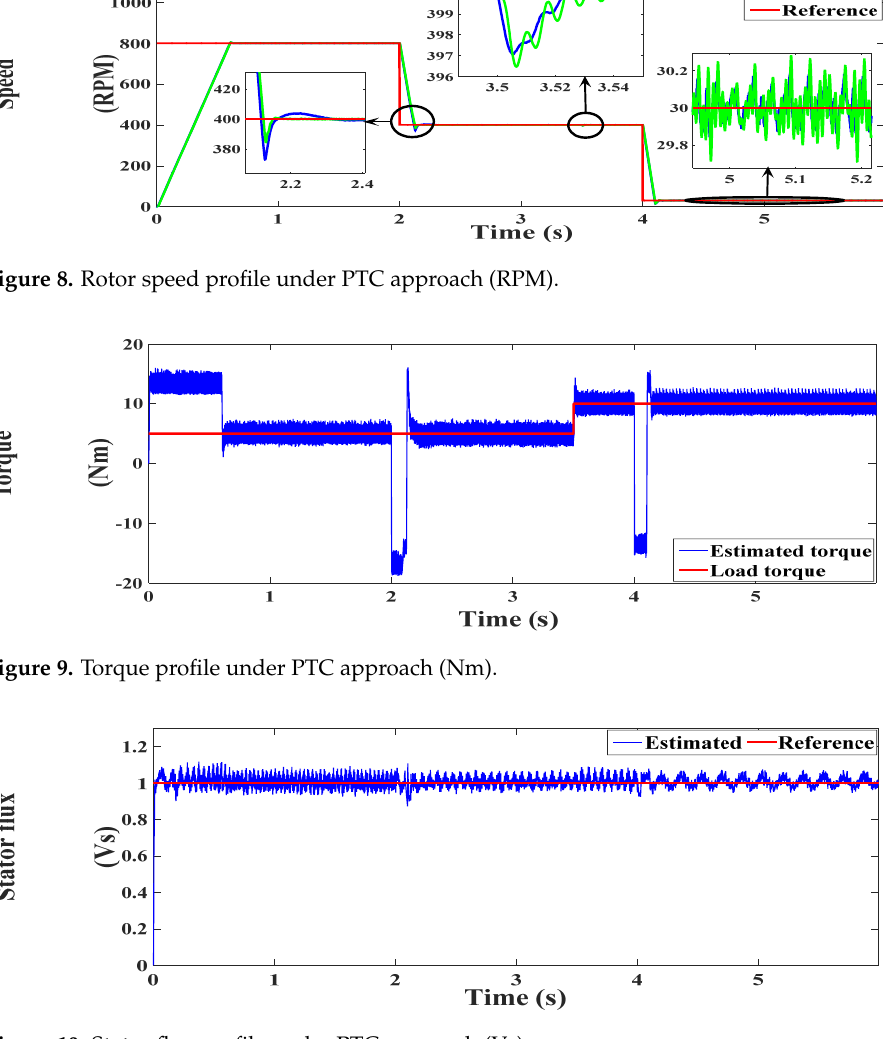
Figure 10. Stator flux profile under PTC approach (Vs).